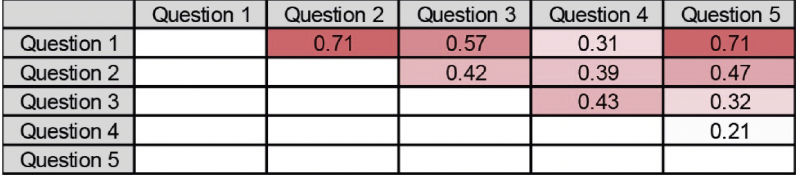
Figure 8. Contingency coefficient among the polytomous variables of the